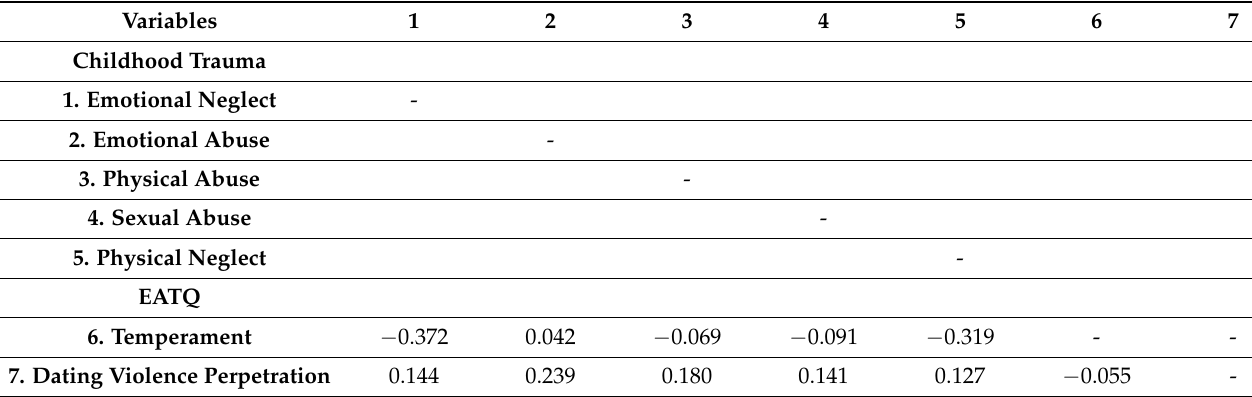
Table 2. Correlations (r) among Variables of